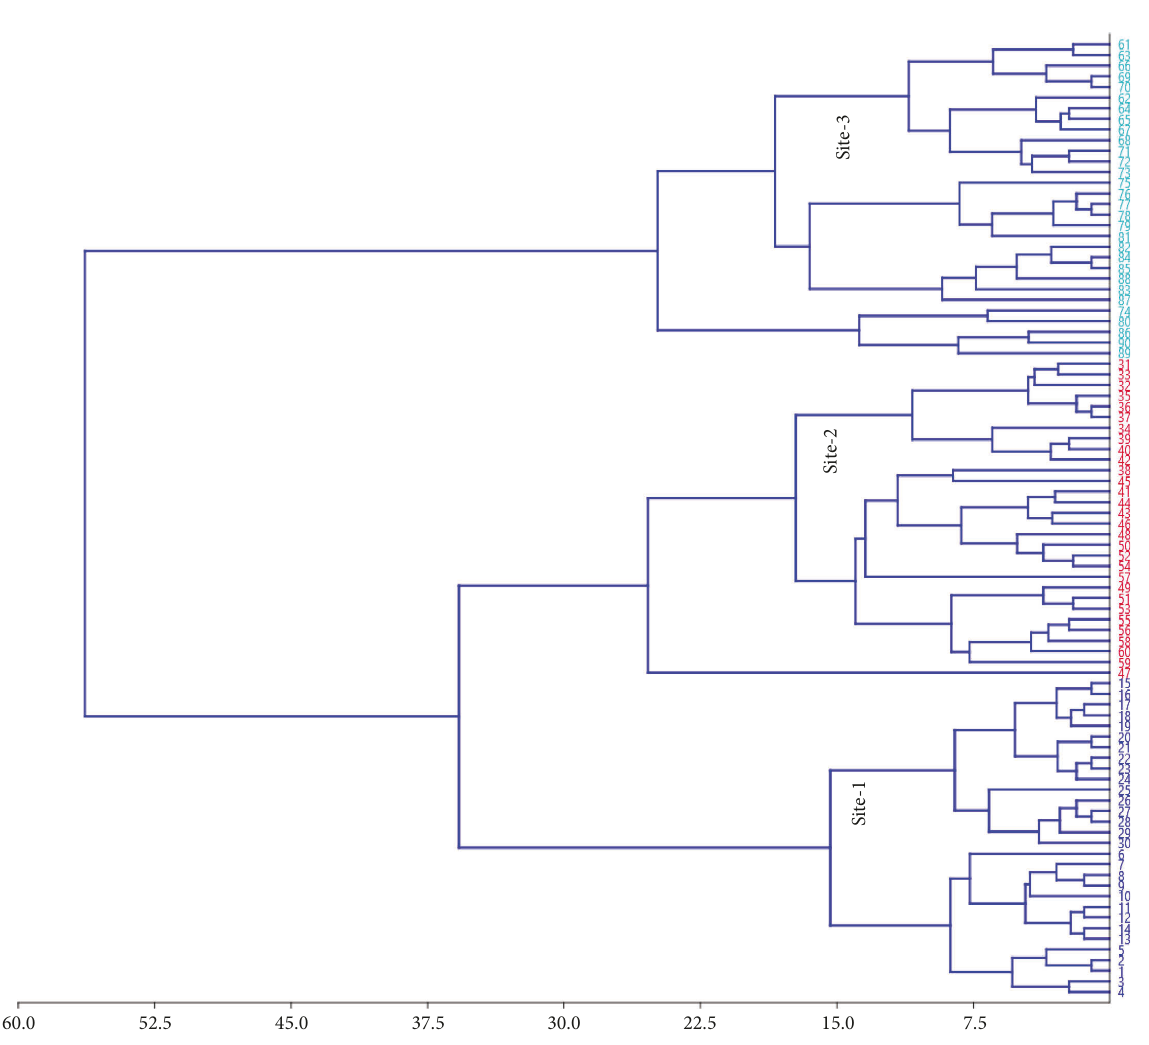
Figure 3: Dendrogram showing the number of plant species of sample plots in three distance sites of the study